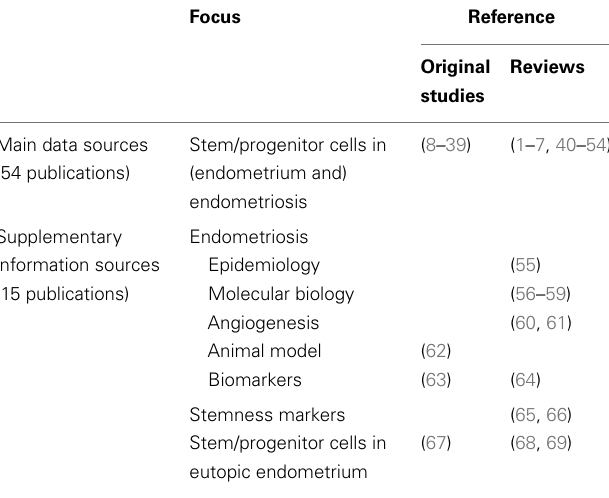
Table 1 | Publications included in the review